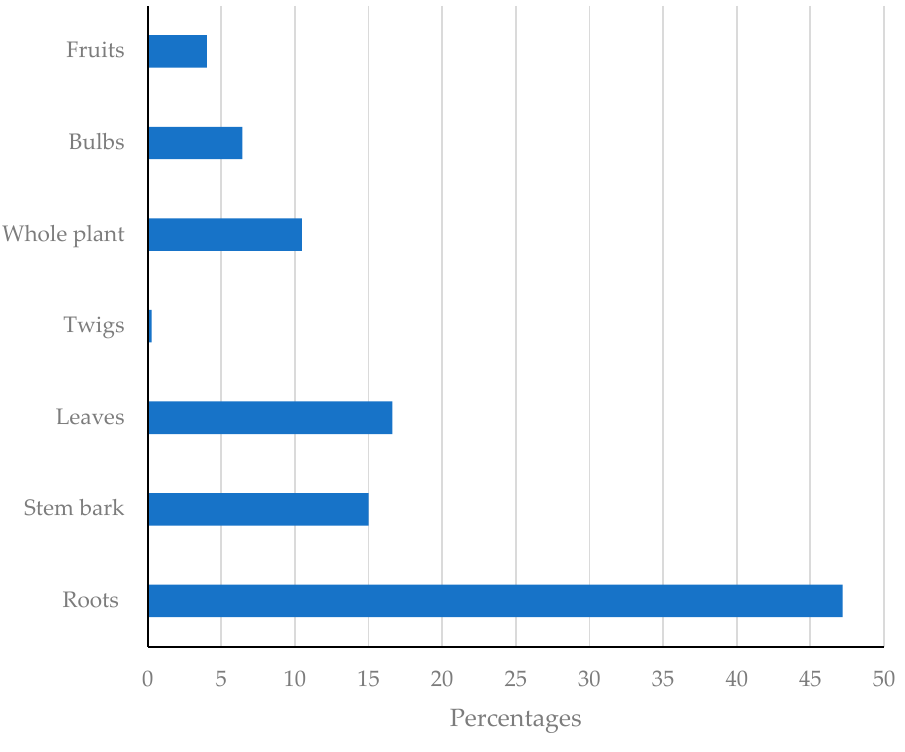
Figure 5. Various percentages of the plant parts used to treat sexually transmitted and related infec- tions.